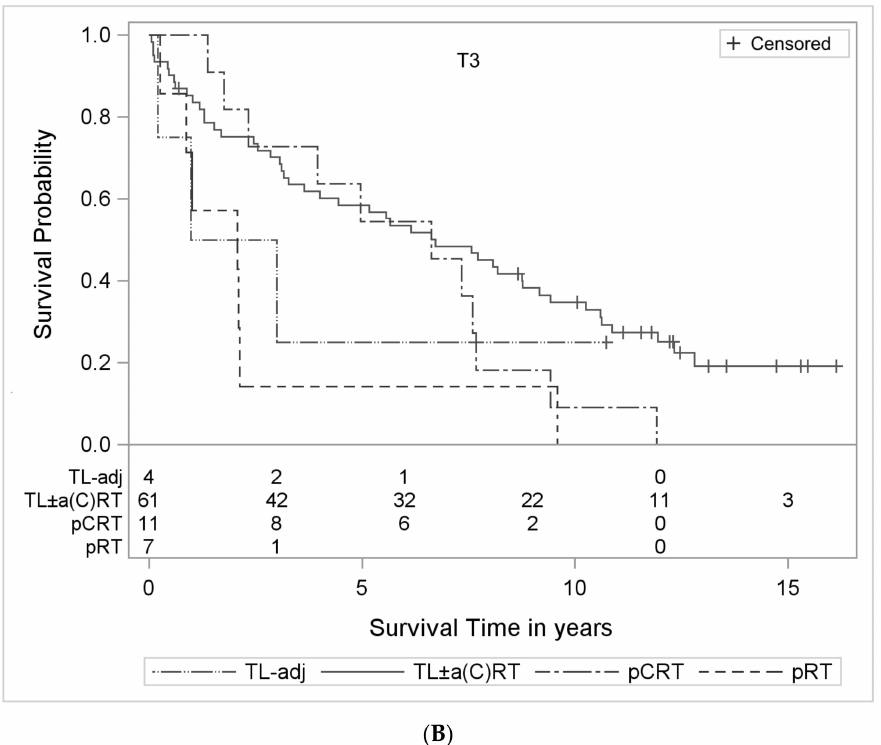
Figure 1. OS after surgical and nonsurgical treatments evaluated over stage III and T3: ( A ) Kaplan– Meier curves with numbers at risk of stage III laryngeal cancer patients in the three treatment arms. TLM: transoral laser microsurgery; OPL: open partial laryngectomy; TL: total laryngectomy; pCRT: primary radiochemotherapy; pRT: primary radiotherapy; ( B ) Kaplan–Meier curves with num- bers at risk of T3 laryngeal cancer patients in the three treatment arms. Total laryngectomy (TL) patients were subdivided into TL with stage-appropriate adjuvant treatment (TL ± a(C)RT) and TL without adjuvant treatment despite N2–3 (TL −